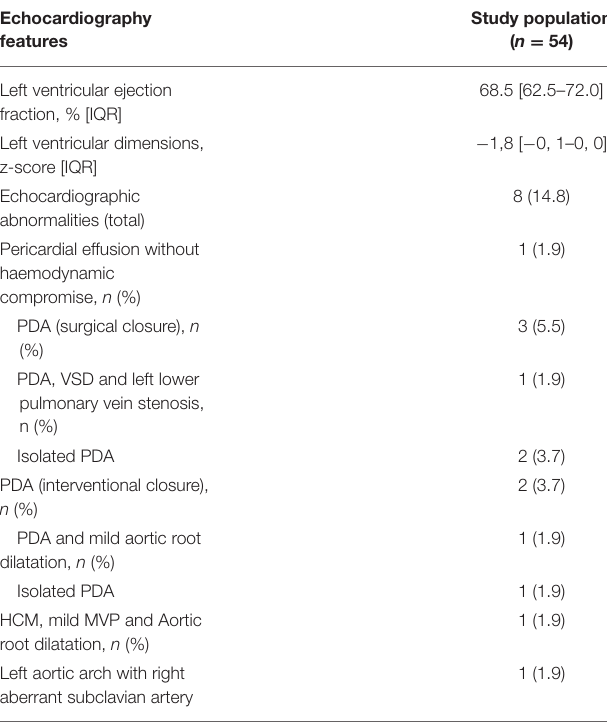
TABLE 3 | Overall conduction defects in congenital DM1 patients with at least one 12-lead ECG including 12-lead ECG and ambulatory ECG monitoring data. Conduction defects